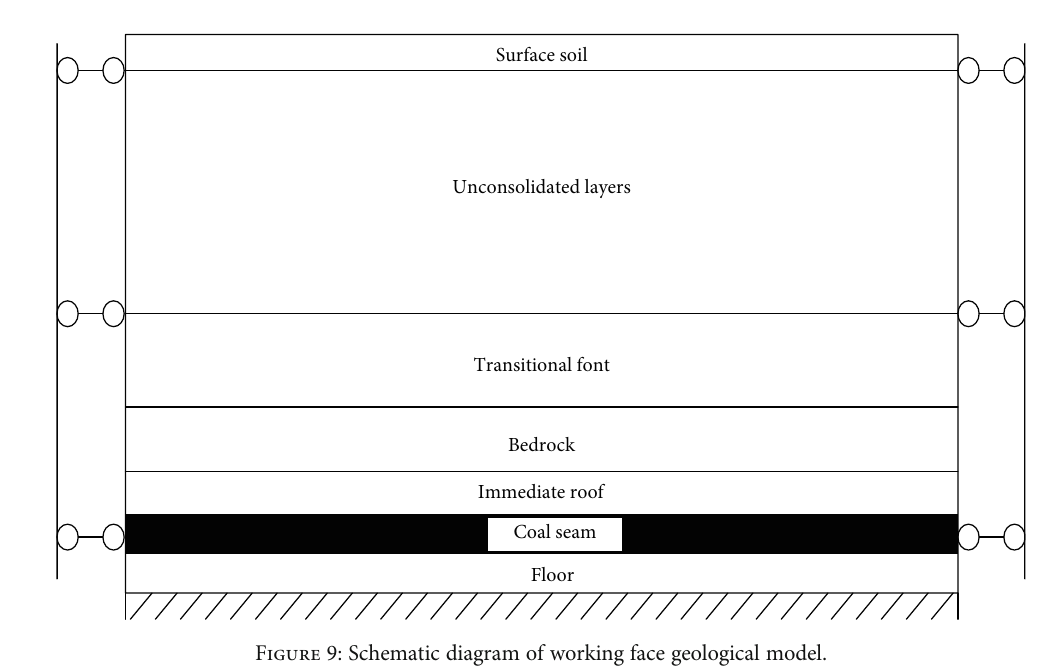
Figure 8: Schematic diagram of FLAC model.